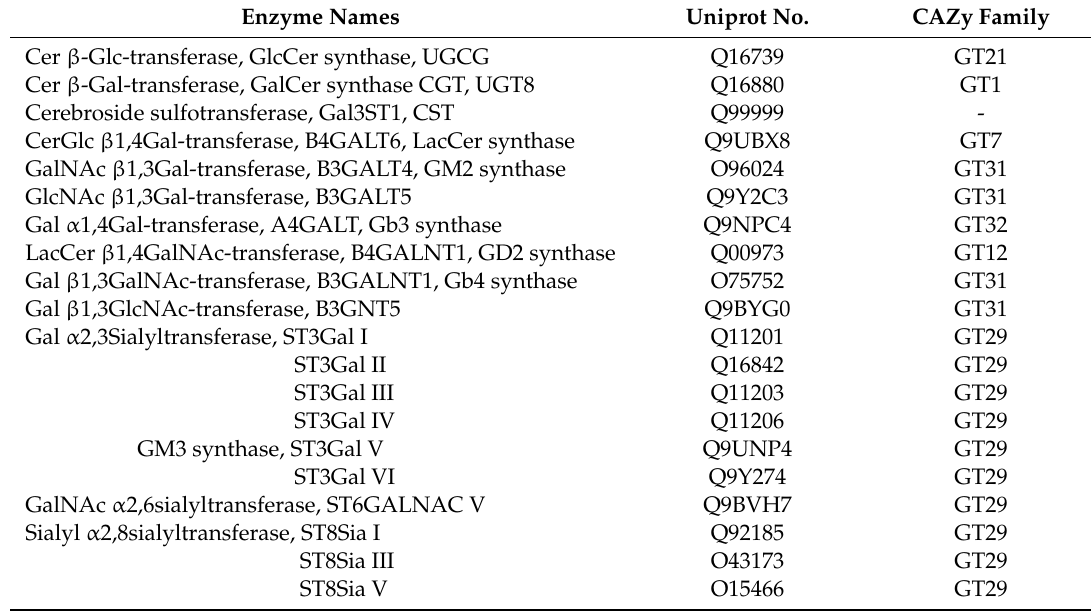
Table 1. Human transferases involved in the biosynthesis of glycosphingolipids. Enzyme